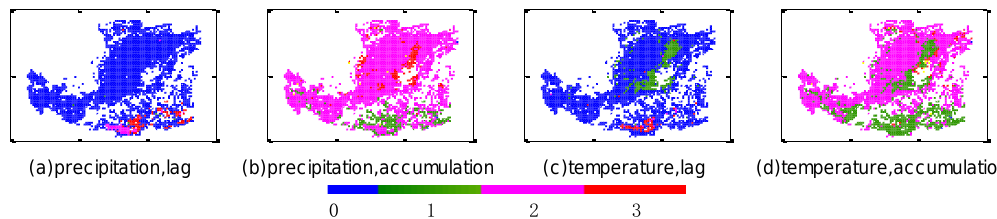
Figure 7. Time lag and accumulations of climate impact on vegetation formulated by method 3.